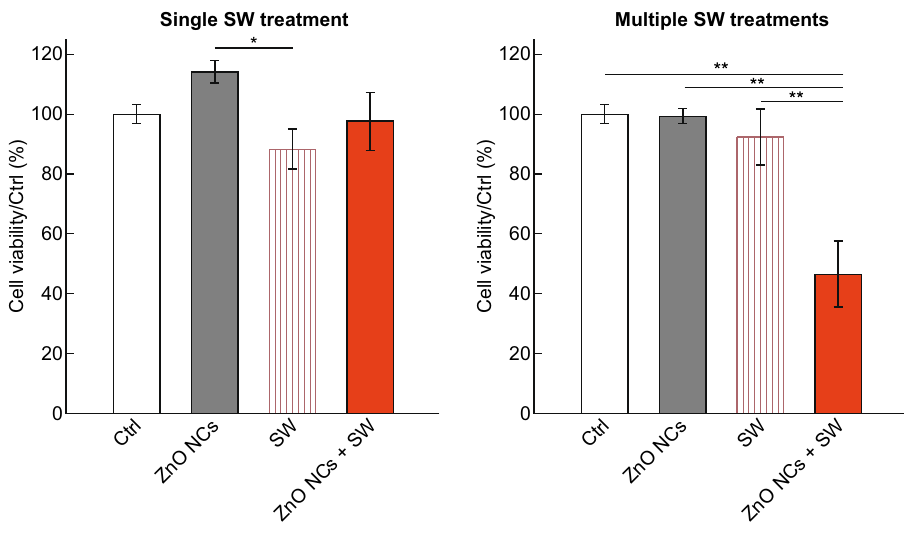
Fig. 12 Comparison between single toward multiple SW treatments on cancer cells co-incubated with ZnO NCs. Samples: untreated cells (Ctrl), cells incubated with ZnO NCs (ZnO NCs), cells treated with SW (SW), cells incubated with ZnO NCs and treated with SW (ZnO NCs + SW). Results are shown as mean ± SEM. * p < 0.05, ** p < 0.01. Adapted from Ref.